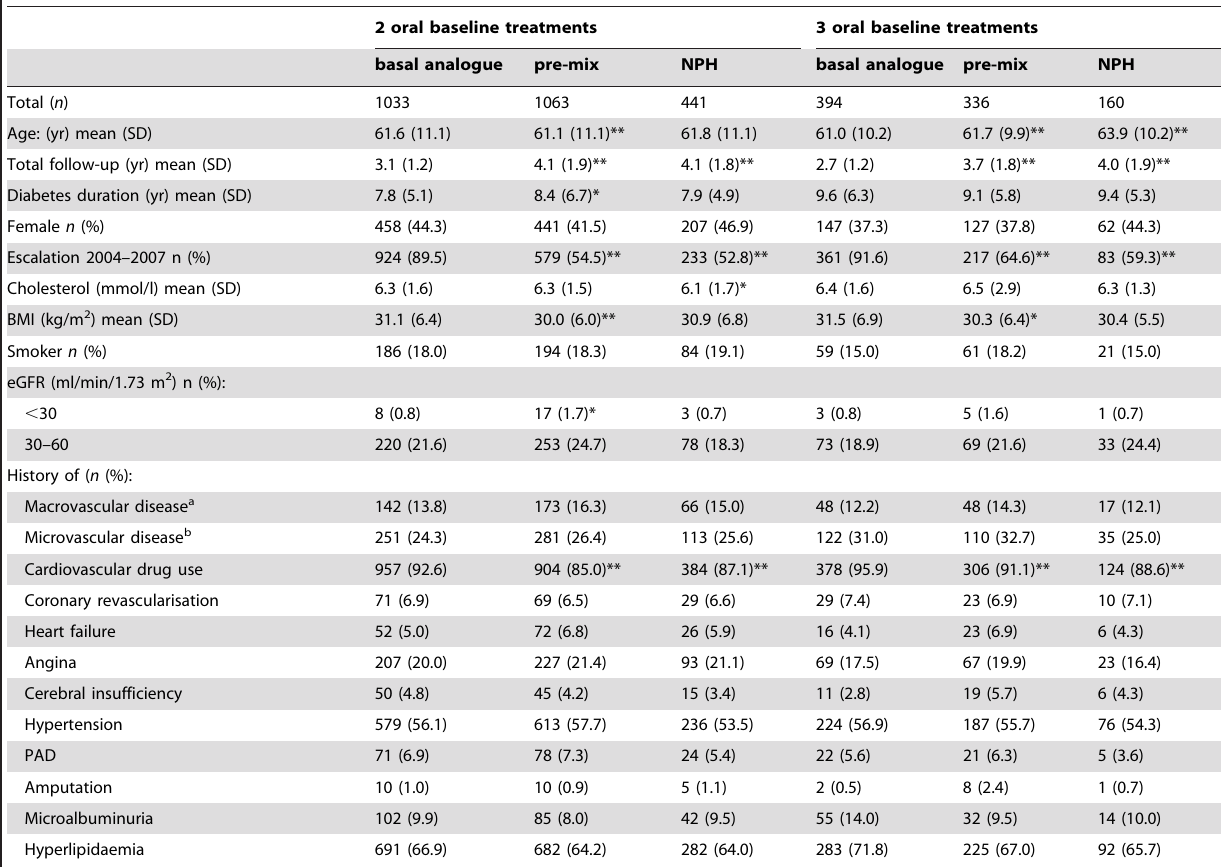
Table 1. Characteristics of the insulin